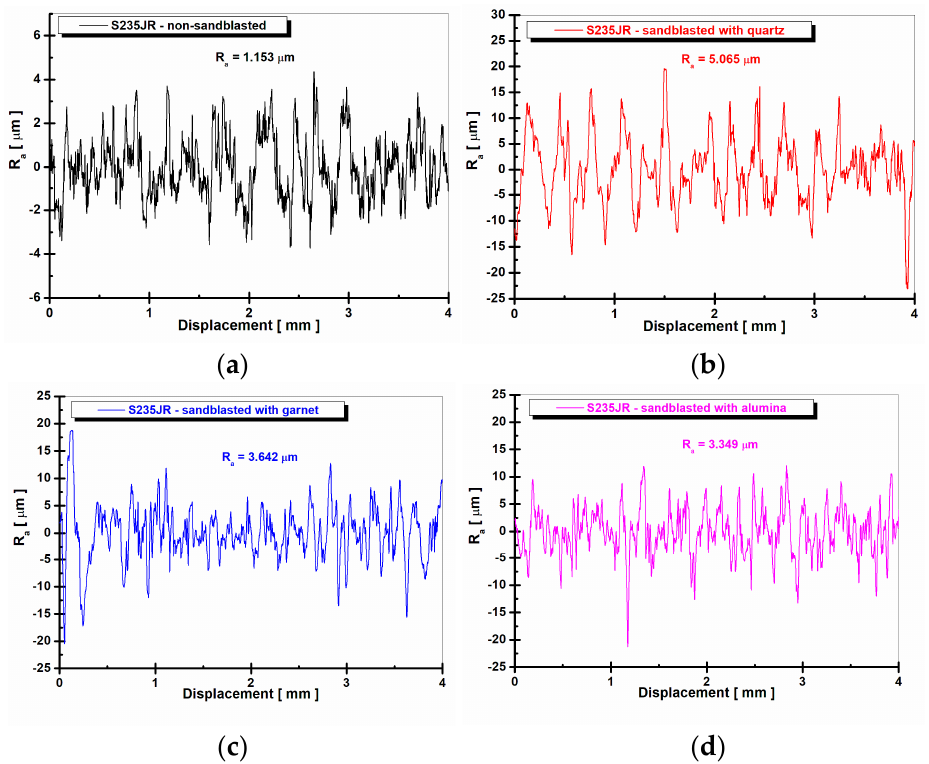
Figure 7. 2D surface profile of surface roughness after corrosion of S235JR immersed during 336 h in 3.5 NaCl solution for: ( a ) S235JR—non ‐ sandblasted, ( b )—S235JR—sandblasted with quartz, ( c )—S235JR—sandblasted with garnet, ( d )—S235JR—sandblasted with alumina. Table 5. Roughness parameter values for the tested surfaces before and after the corrosion pro ‐ cess.